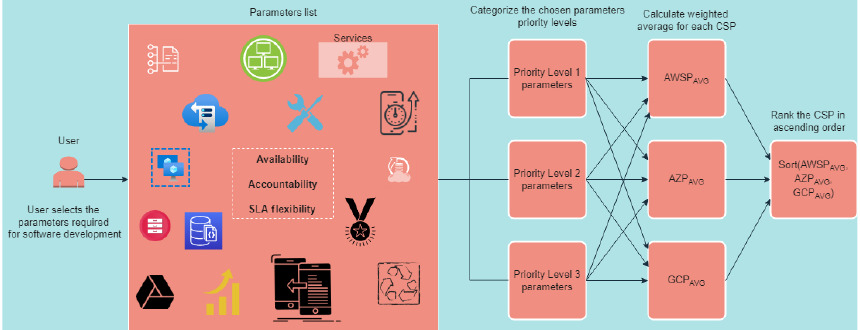
Fig. 3 Process diagram for the PRPLW-based CSP selection